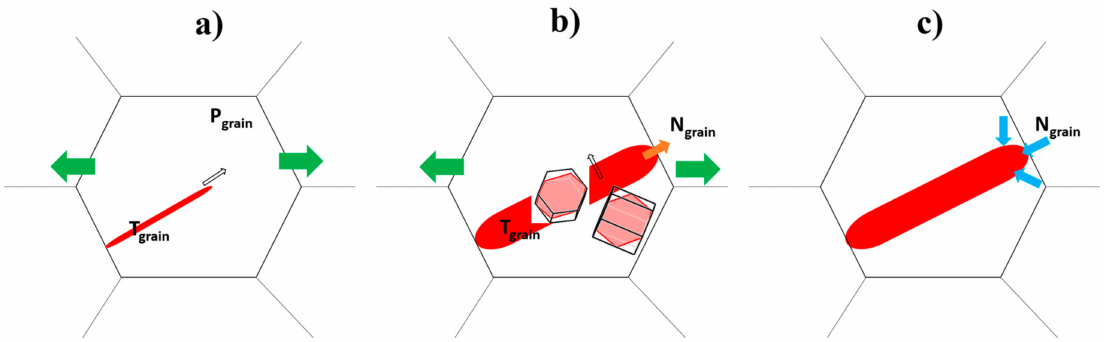
Figure 9. ( a ) Schematic showing twin propagation in a parent grain, applied stress in the present study is depicted by green arrows, direction of propagation shown by black open arrow; ( b ) twin growth leads to lateral thickening under external stress once the twin hits the grain boundary, the forward stress component driving motion of twinning front (shown in blue arrow) is accommodated in the neighboring grain; ( c ) direction of back stresses acting on the twin in the investigated region during unloading that resist further twin